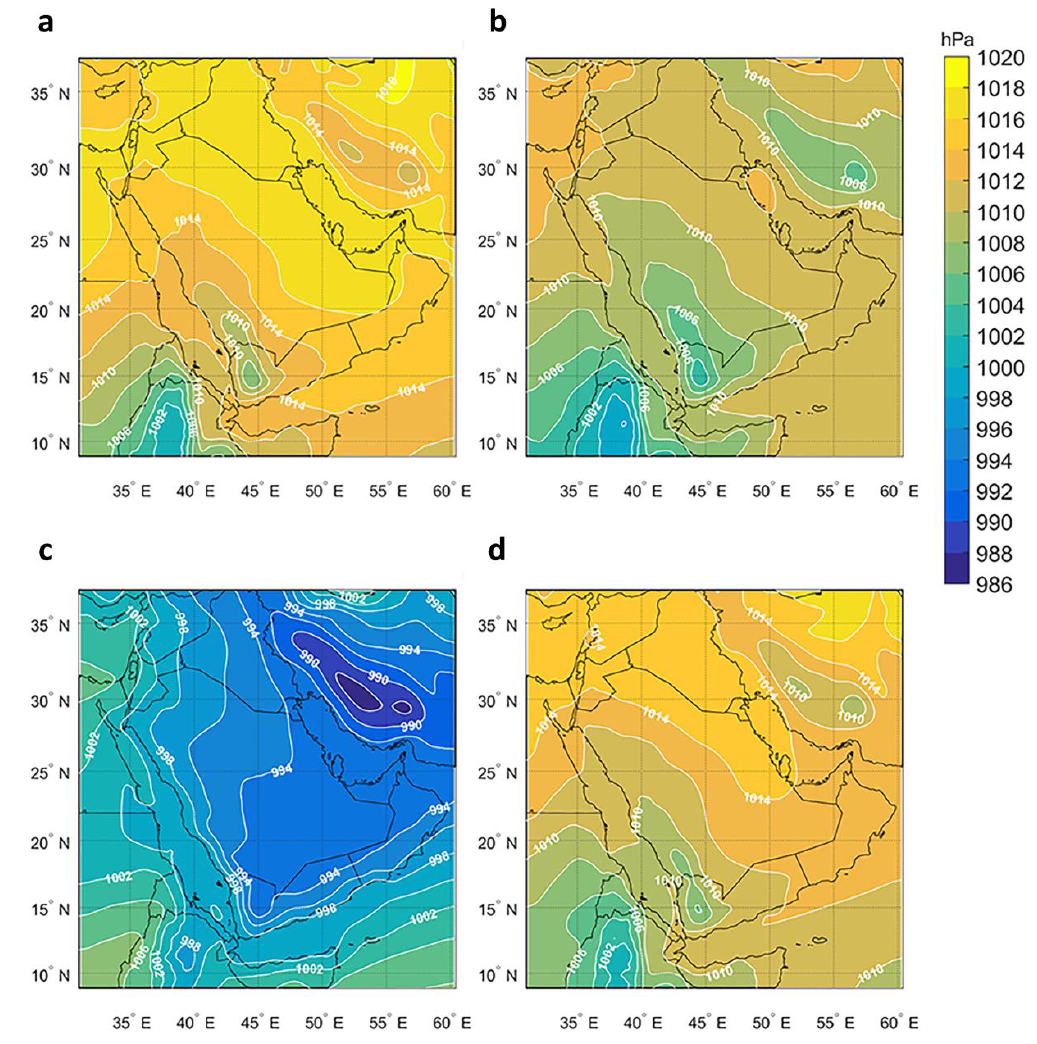
Figure 9. Mean monthly values of Sea Level Pressure for ( a ) January, ( b ) March, ( c ) July and ( d ) November.